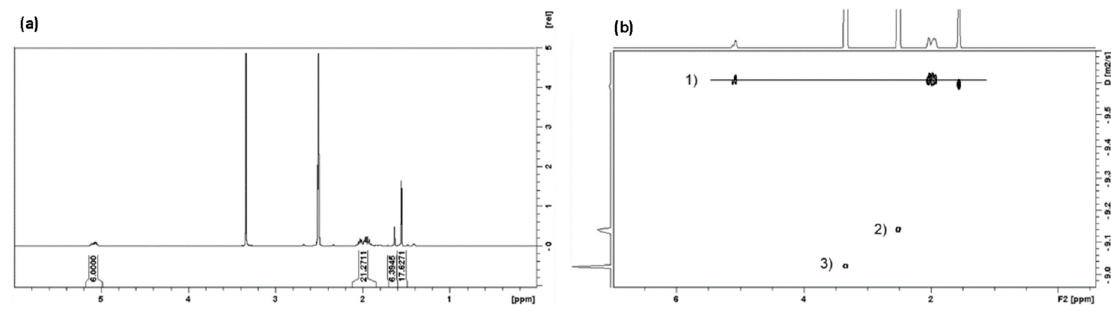
Figure 1. Proton NMR of a commercially available squalene sample ( a ) and DOSY NMR of the same sample ( b ). (1) squalene, (2) DMSO residual and (3) H 2 O. Both spectra were recorded in DMSO-d 6 .